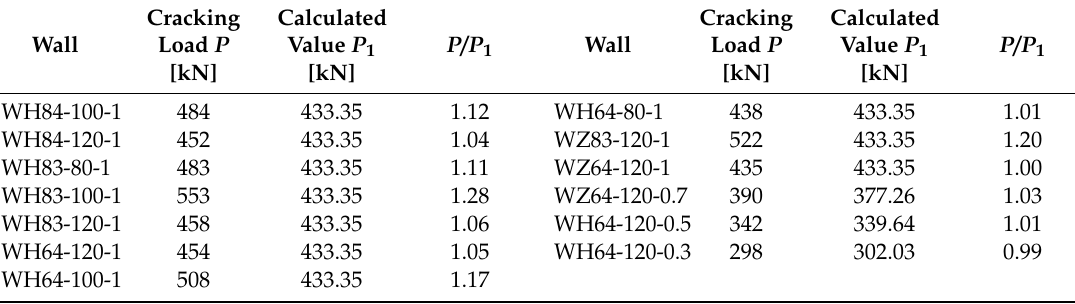
Table 8. Comparison between the calculated value and the test